Question: What style of plot is this figure drawn as?
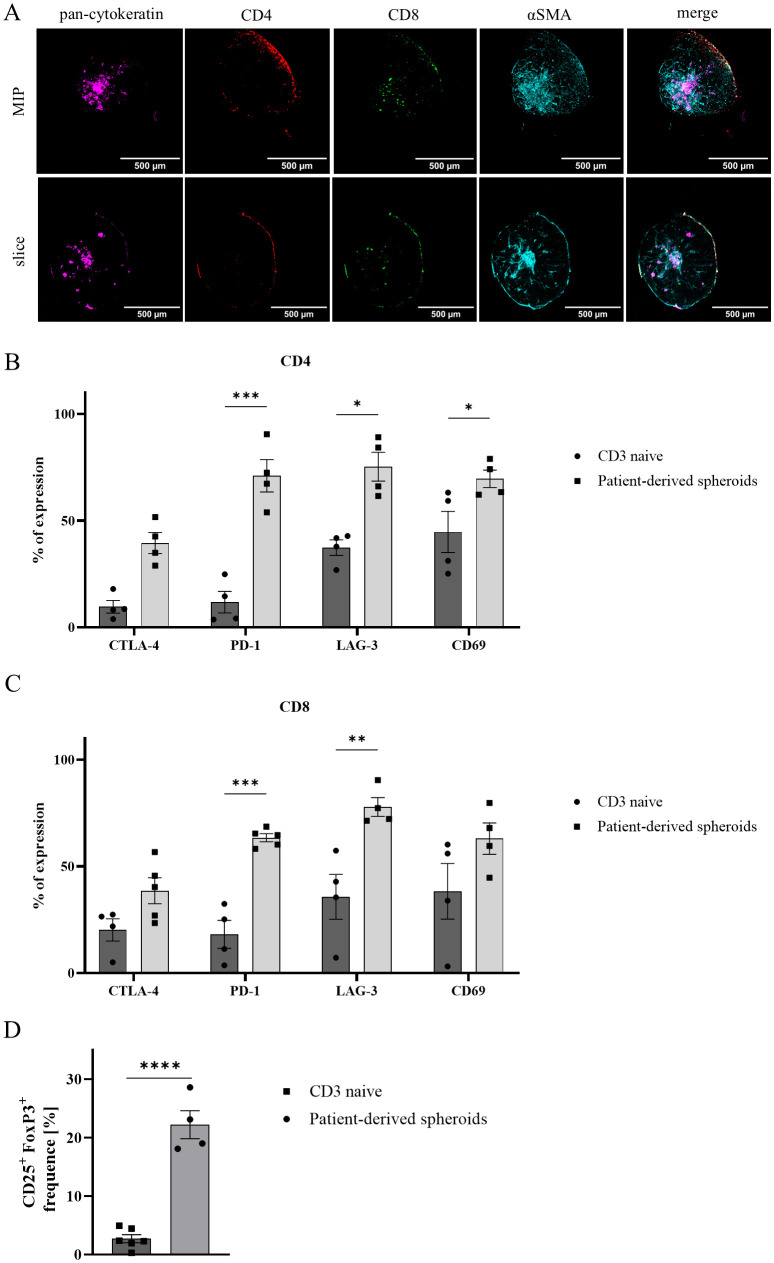
Answer: bar